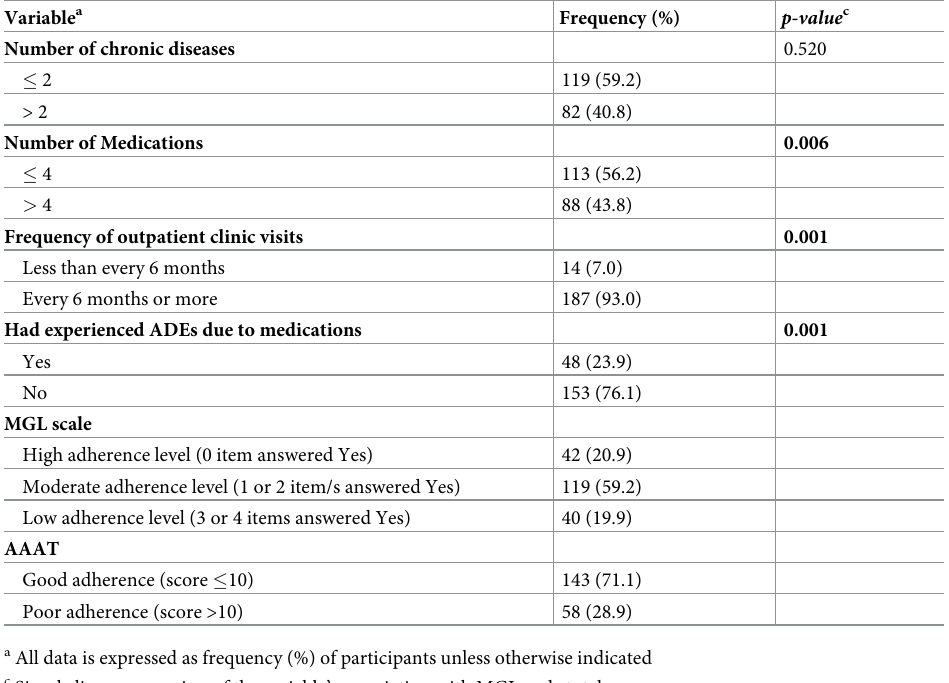
Table 2. Clinical characteristics and medication adherence of the study population (N = 201).